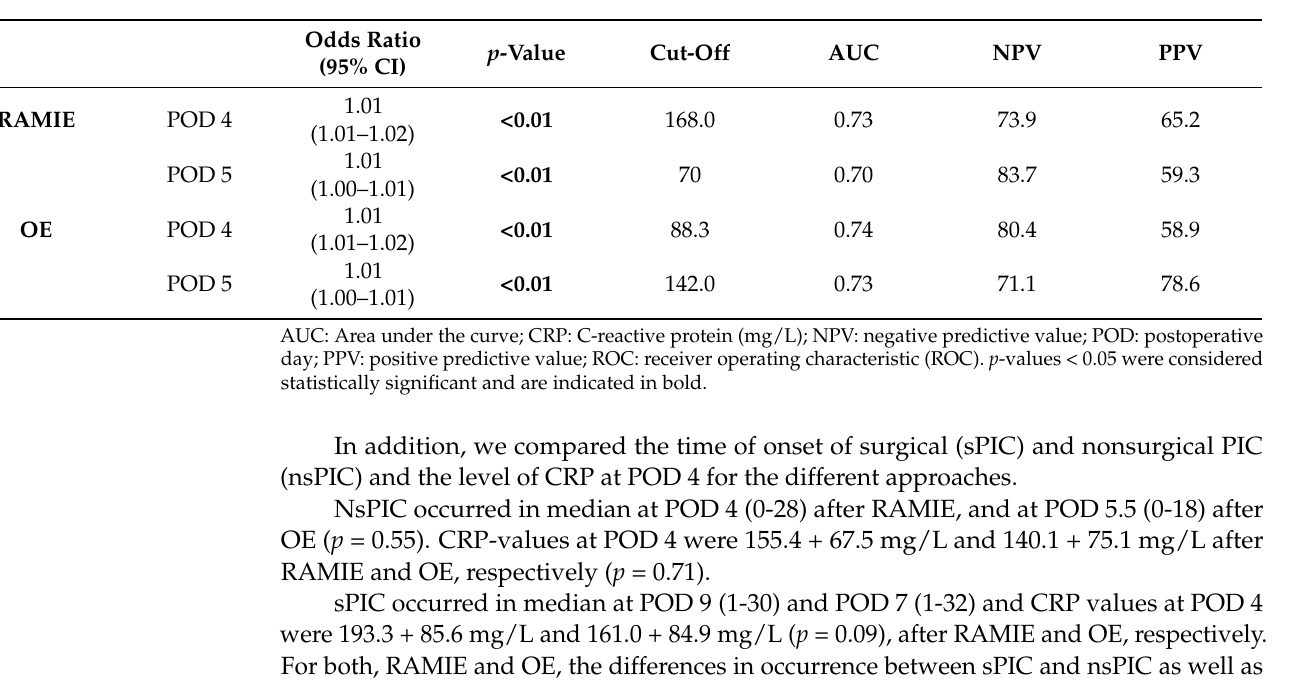
Table 4. Univariate logistic regression of CRP-levels depending on postoperative infectious complica- tions and type of procedure. AUC and ROC-analysis to evaluate the prediction of a PIC. Best cut-off means the highest Youden’s